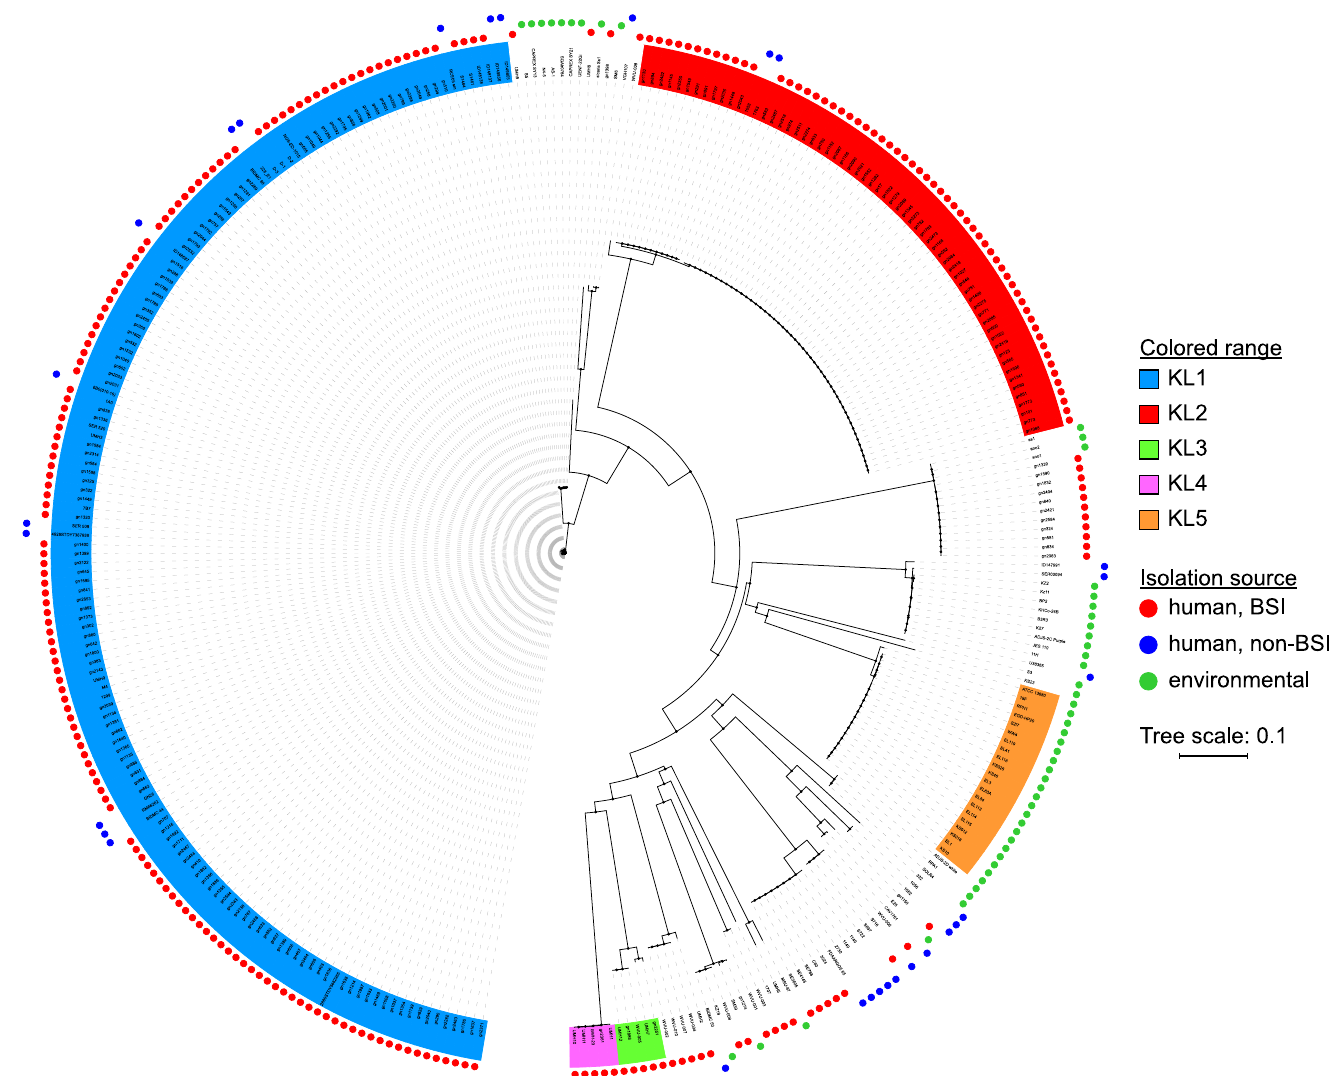
Fig 2. Phylogenetic analysis of the S . marcescens KL. KL were extracted from S . marcescens genome sequences and MAFFT alignments were used to generate a neighbor-joining tree. The isolation source was determined from NCBI genome entry metadata and is indicated by colored circles in the outer rings. Selected clades representing different capsule genetic types are shaded and arbitrarily designated